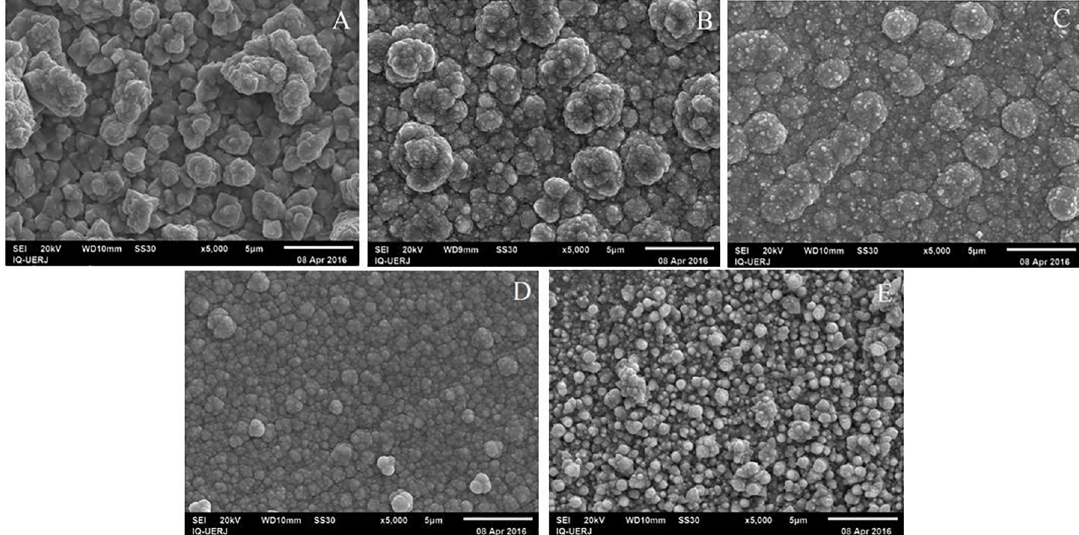
Figure 4. Surface morphology of the Cu-Sn coatings produced using the selected current densities: (A) j = 20 A m -2 ; (B) j = 50 A m -2 ; (C) j = 80 A m -2 ; (D) j = 100 A m -2 ; (E) j = 200 A m -2 .